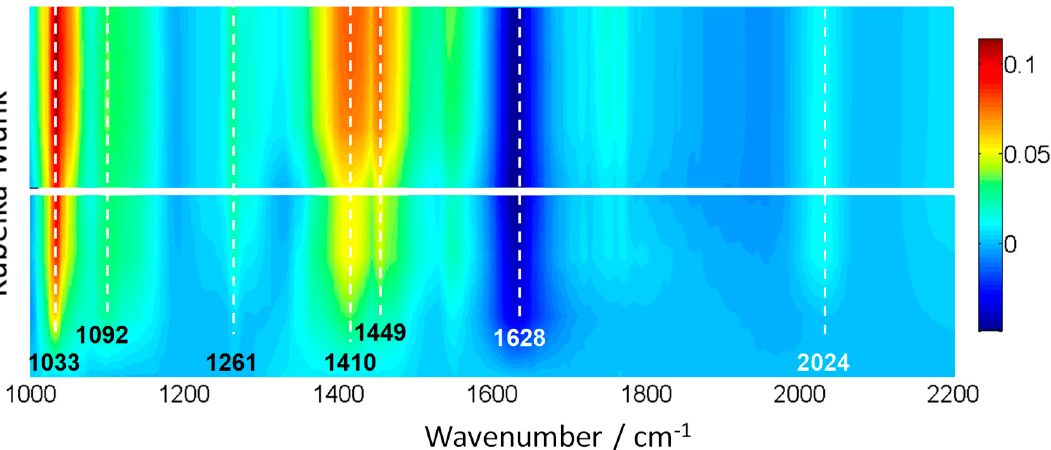
Figure 7. Difference infrared spectra of the T-S sample using a 70/30 methanol/water reaction mixture under dark ( bottom panel ) and illumination ( upper panel ).